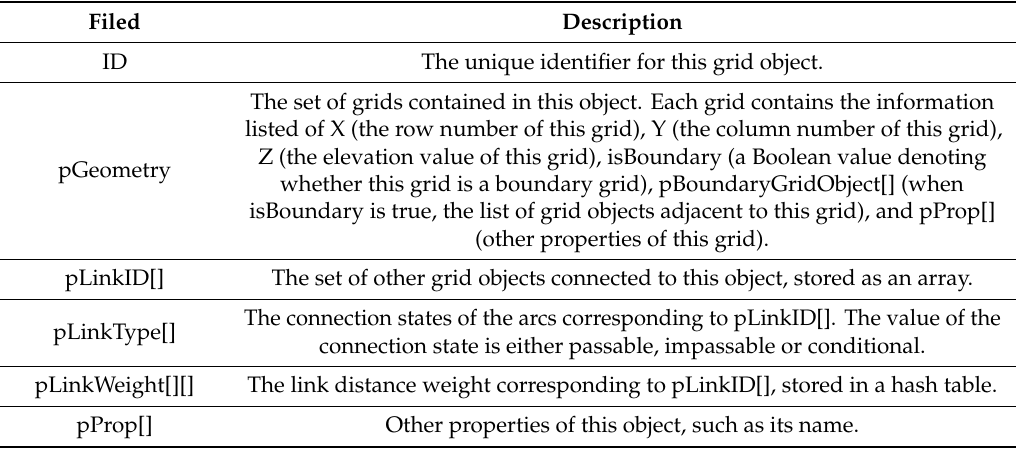
Table 1. The main attribute filed in the CGridObject.